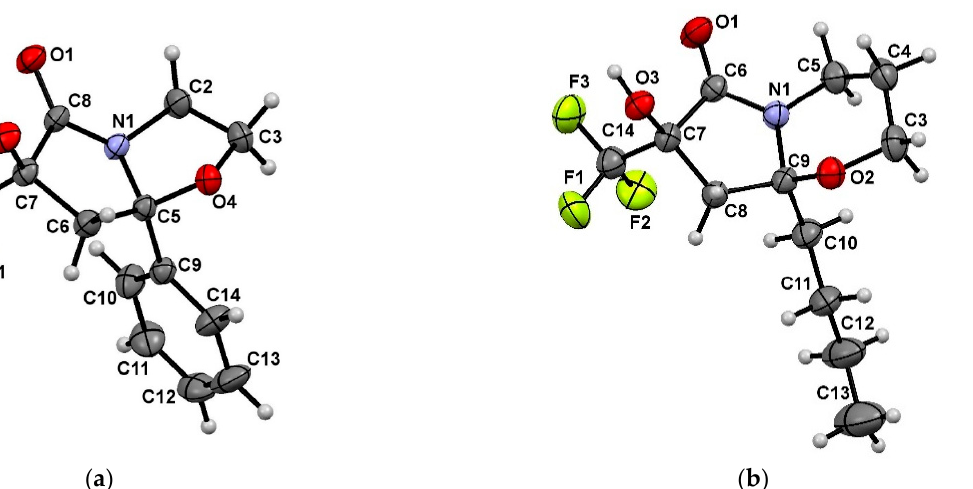
Figure 3. The ORTEP view of compounds 4d c ( a ) and 8c c ( b ) according to XRD data.